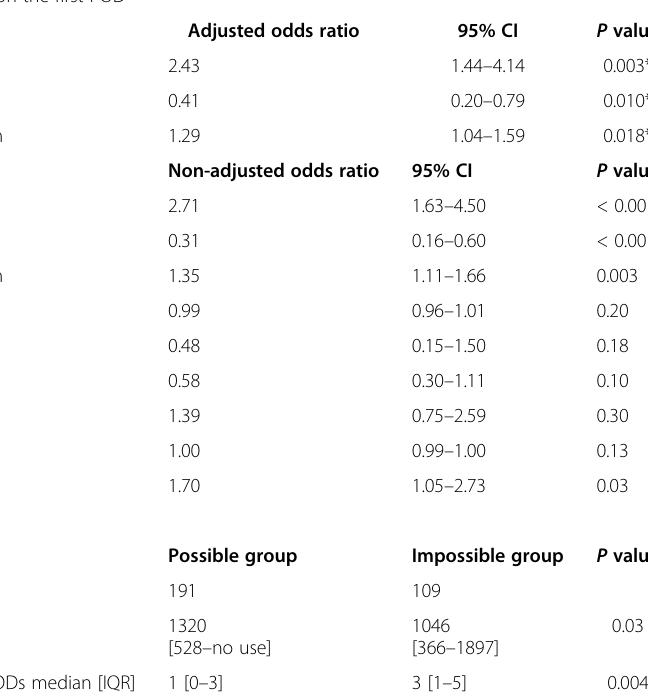
Primary outcomes Logistic regression analysis for infeasibility of walking rehabilitation on the first POD